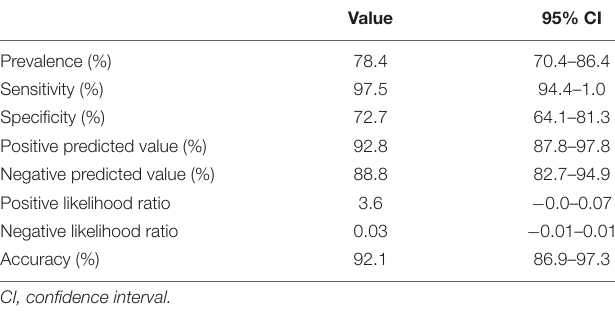
TABLE 4 | Evaluation of Airgo TM performance vs. Nox T3 in classifying OSA severity ( n = 102).